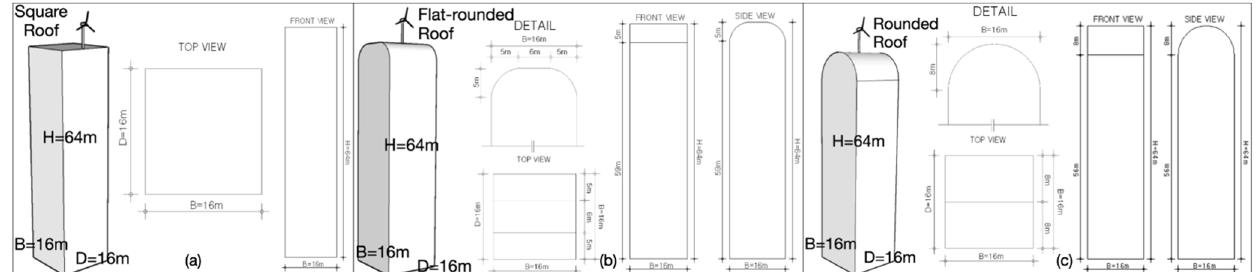
Figure 4. Detailed geometry of the building models (scale 1:150) used for the experiments: ( a ) square